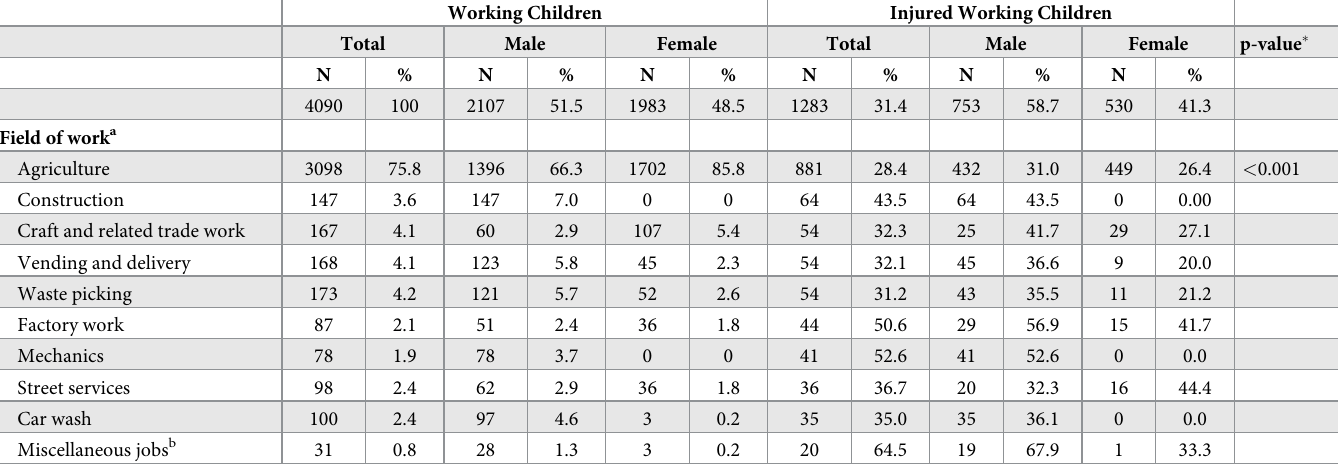
Table 3. Distribution of Syrian refugee working children (8–18 years) and those reporting injuries across field of work in the Bekaa Valley, Lebanon, 2017 (N = 4090).